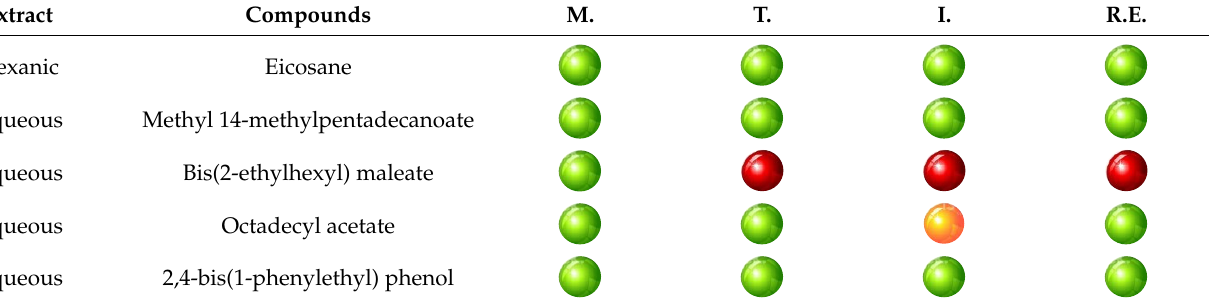
Table 5. Toxicity Risks by OSIRIS Property Explorer.